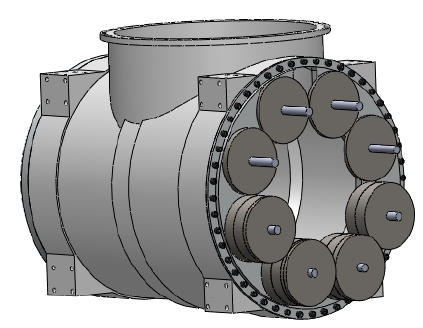
Figure 6. Computer model of the counterweights